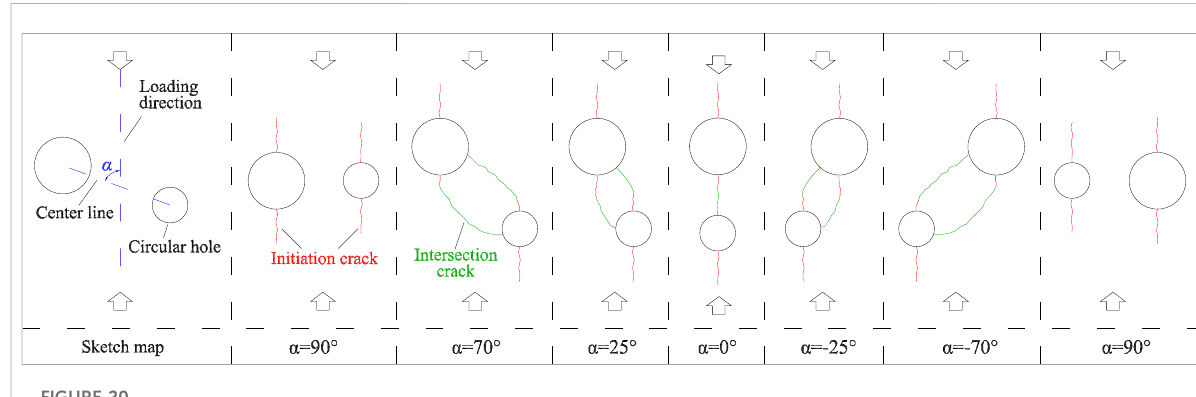
FIGURE 20 Basic crack initiation, propagation, and intersection mode of two adjacent circular